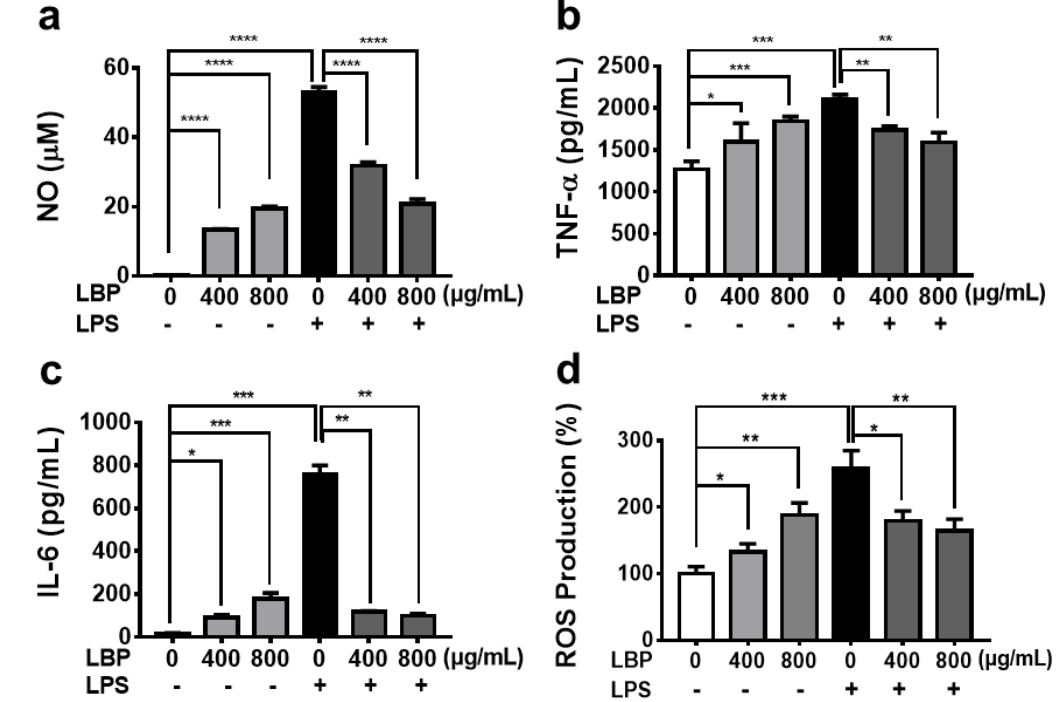
Figure 3. Inflammatory regulation of LBP on macrophages. The releases of NO ( a ), TNF-α ( b ) and IL-6 ( c ) from RAW264.7 cells after treatment by LBP > 10 kDa and LBP > 10 kDa + LPS (1 µg/mL). ( d ) The production of ROS in RAW264.7 cells after treatment by LBP > 10 kDa and LBP > 10 kDa + LPS (1 µg/mL). Results were expressed as means ± SD, n = 3. * p < 0.05, ** p < 0.01, *** p < 0.001, **** p < 0.0001.